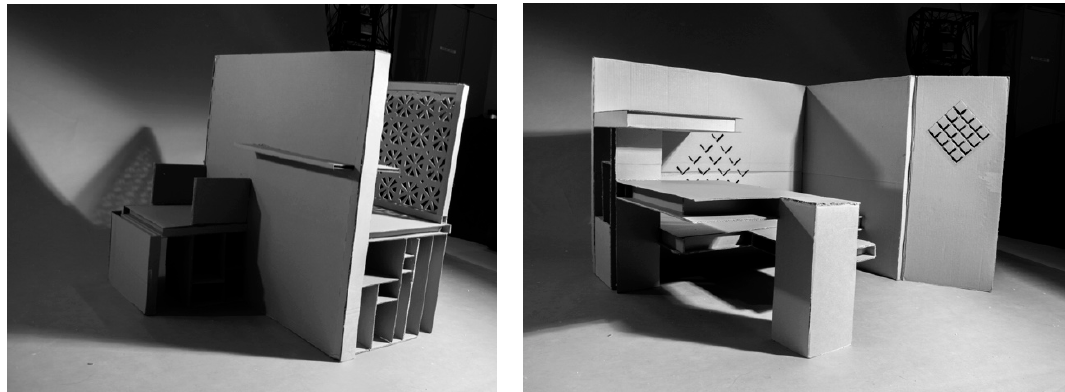
Figure 10. Two examples of the 1:2 scale cardboard prototypes.